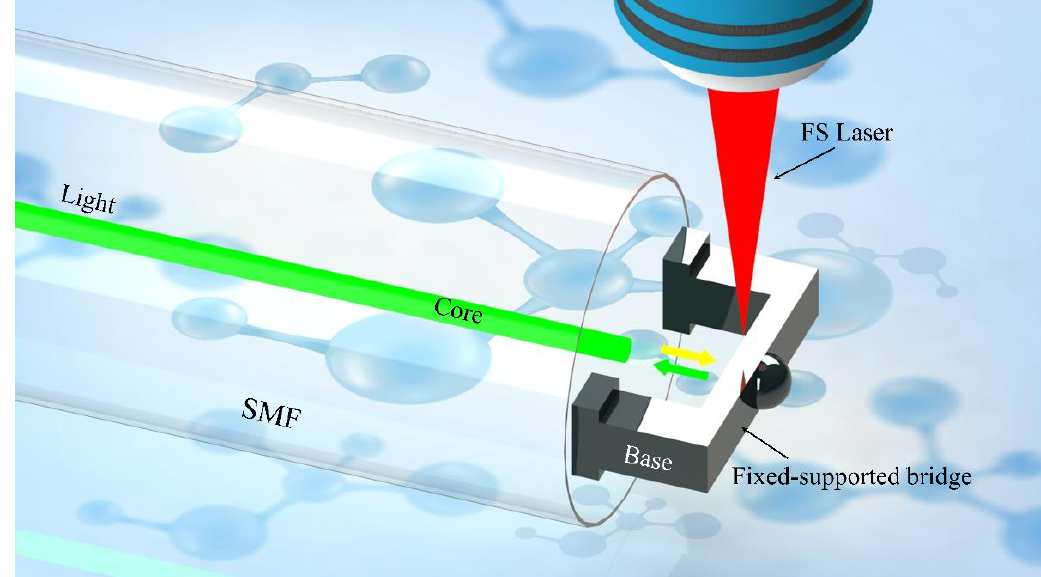
Figure 1. The schematic design of the all-fiber glucose sensor is based on the FP cavity.